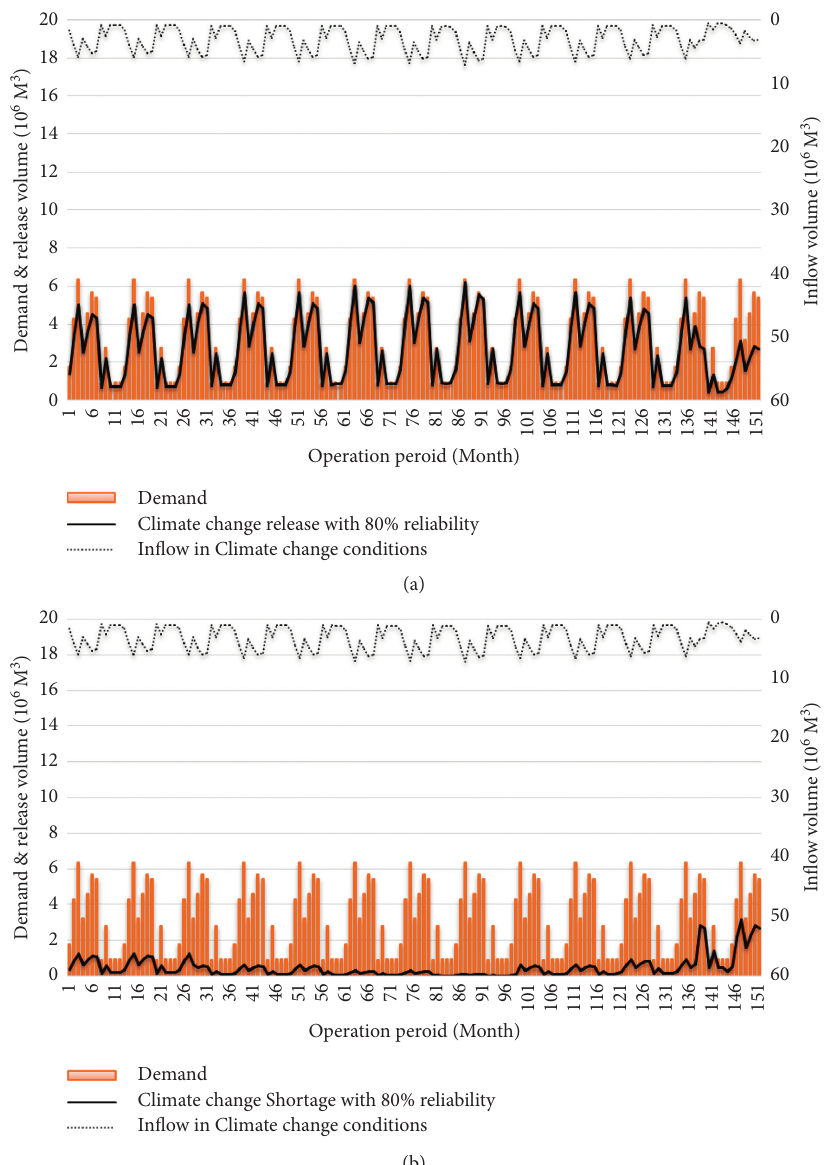
Figure 8: The comparison of (a) release volume and (b) shortage volume per each Pareto point resulted from 75% reliability in climate change conditions. Table 1: The comparison of objective functions in baseline and climate change conditions for each Pareto point (75% reliability).